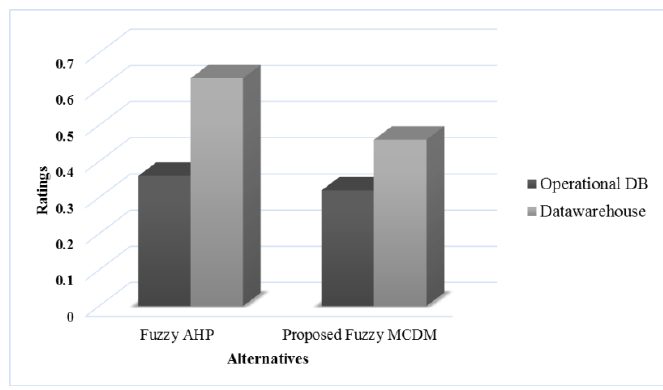
Figure 3. Rating alternatives with FMCDM (TFN-based) and Fuzzy AHP